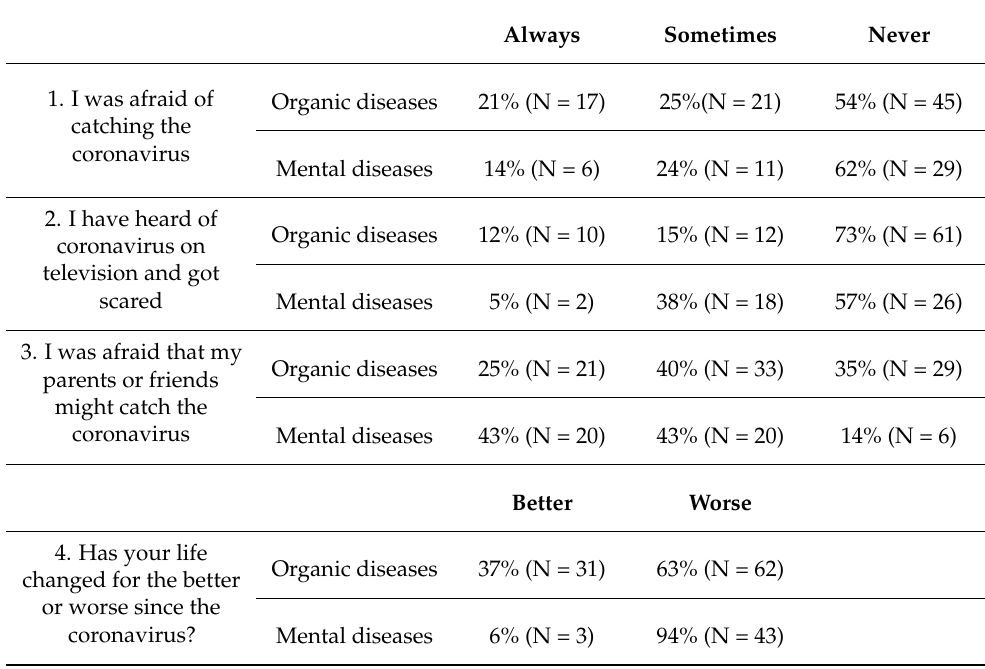
Table 3. Emotional experience and feelings towards the pandemic within the fragile group (organic vs. mental diseases) (n =